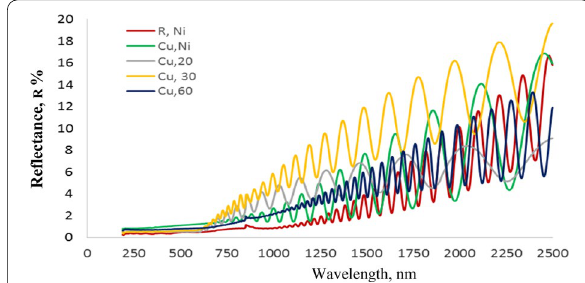
Fig. 7 Reflectance measurements of colored samples by Ni, mixed Ni and Cu, Cu (20 min), Cu (30 min) and Cu (60 min)